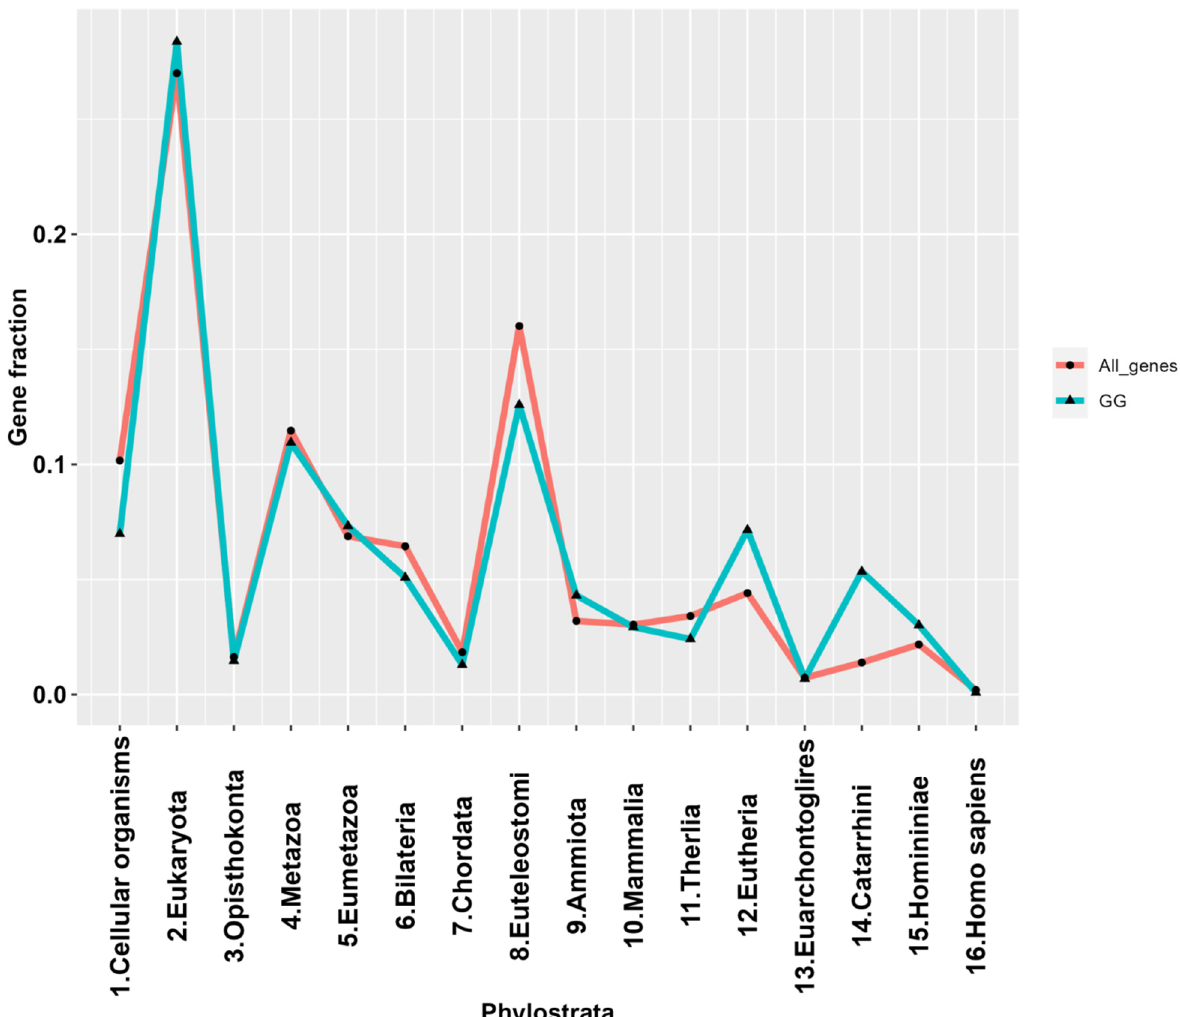
Figure 2. The phylostratigraphic distribution line plot of genes in the GG list (n = 1474), with all available genes serving as a reference.